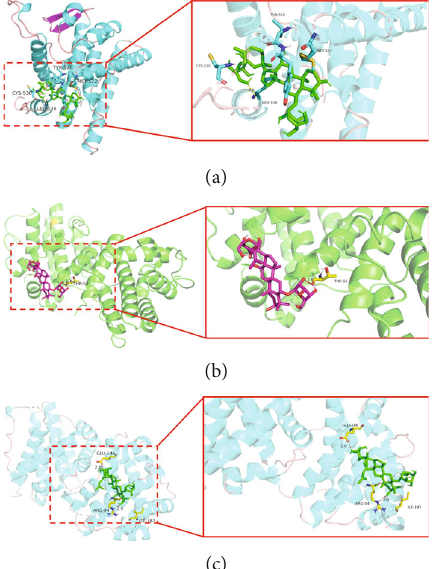
Figure 7: Molecular docking pattern and results. (a) Molecular docking results of Rg1 and GPR30; (b) molecular docking results of Rg1 and Bax; (c) molecular docking results of Rg1 and Bcl-2. Binding energy between Rg1 and GPR30, Bcl-2, or Bax was -4.69, -0.53, and